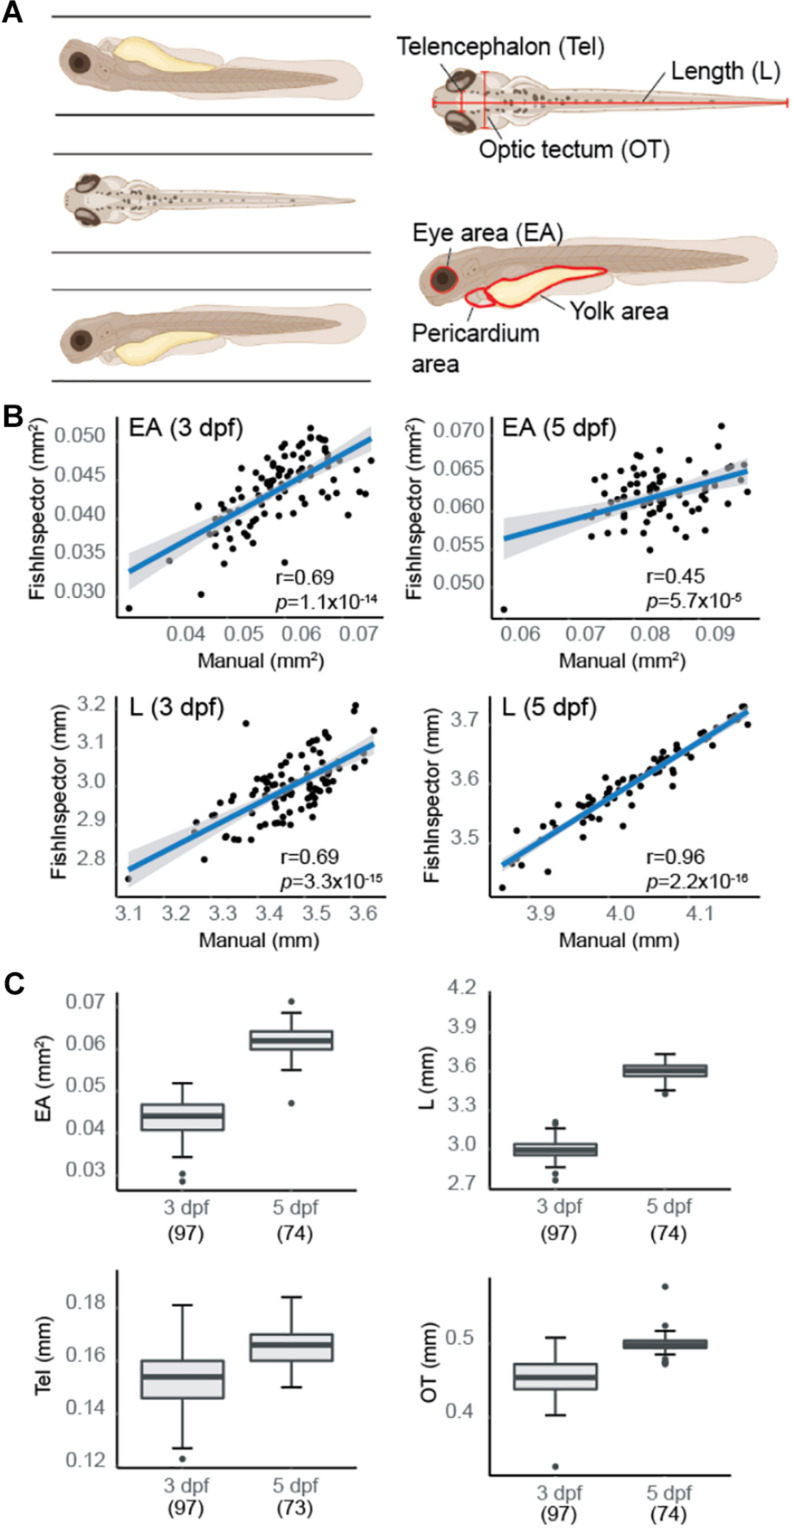
Morphometric-phenotype assessment of larvae at 3 days post fertilization (dpf) and 5 dpf. (A) Larval fish were imaged in three orientations (dorsal, right lateral, and left lateral) using the VAST system. Morphometric features were obtained manually using Fiji [body length (L), eye area (EA), telencephalon (Tel), and optic tectum (OT)] and automatically using FishInspector (L, EA, head width, pericardium area, and yolk area). (B) Manual and automated measurements were compared with L and EA (averaged between both eyes) showing high correlations at 3 dpf (n = 97) and 5 dpf (n = 73) (Pearson correlation). Blue line represents the fit of a linear model with 95% confidence intervals. (C) Boxplots pictured represent distribution of measurements for larval morphometric features obtained via automated (L and EA) and manual (Tel and OT) methods. Boxplots include the median value (dark line), and the whiskers represent a 1.5 interquartile range.